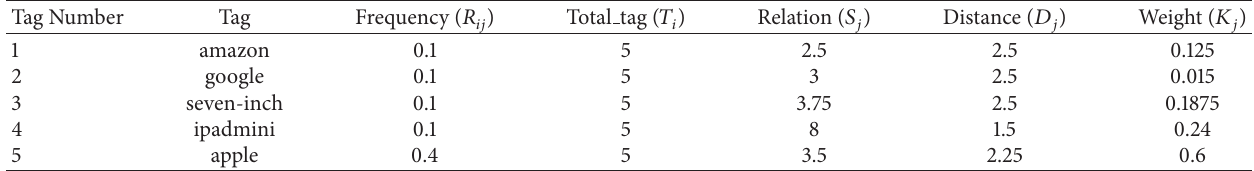
Table 3: Results for valid tags on the “Apple iPad Mini” theme.